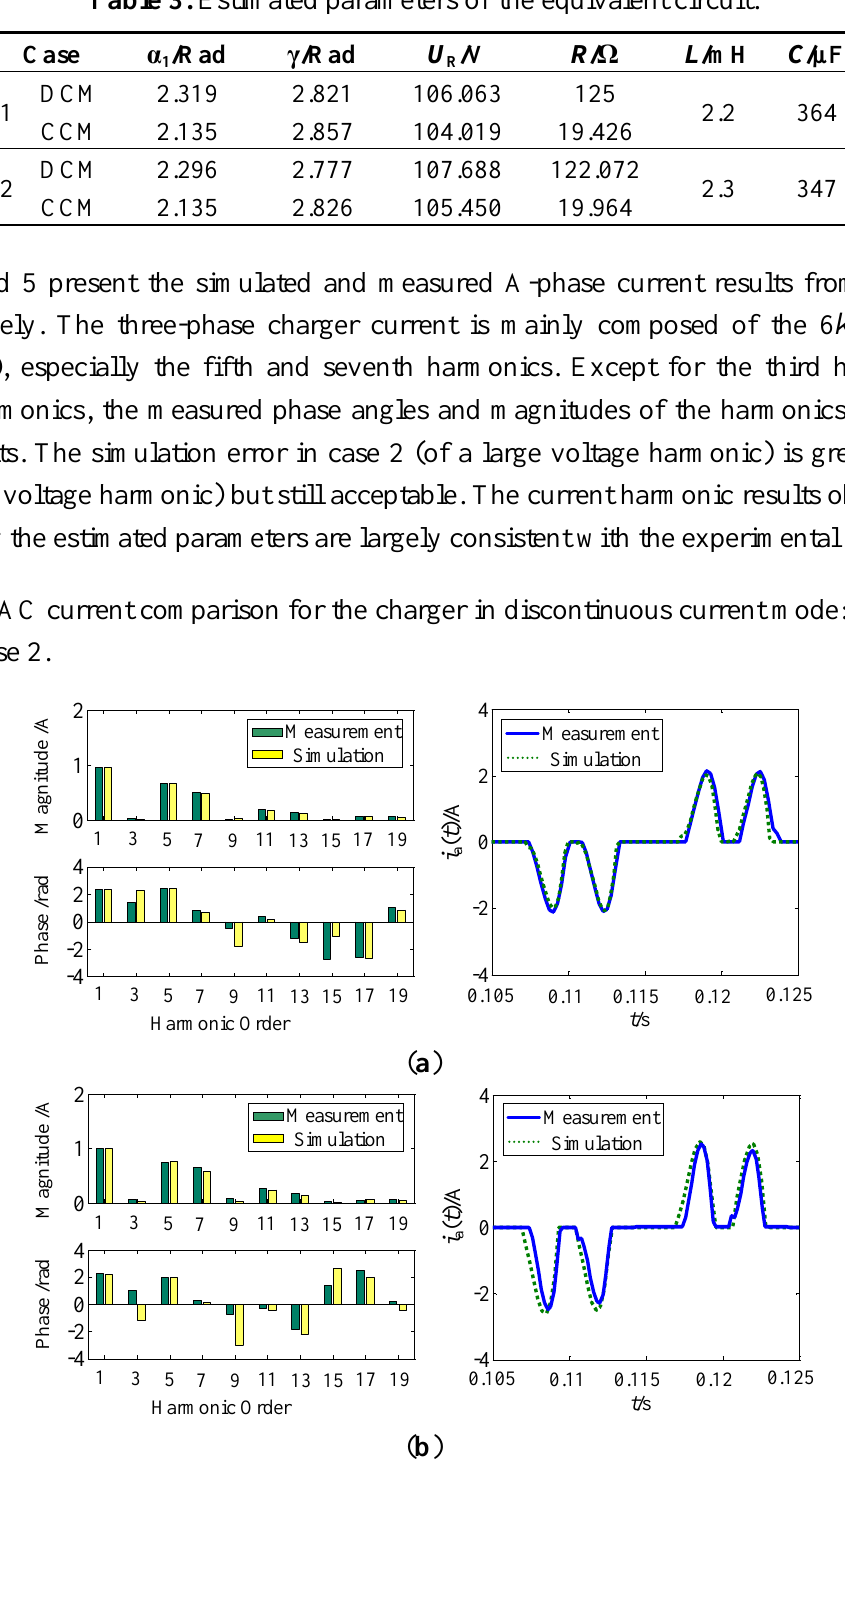
Table 3. Estimated parameters of the equivalent circuit.